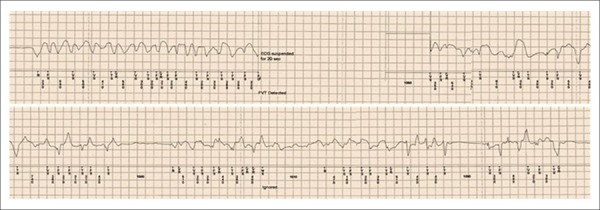
Fatal ventricular tachycardia/fibrillation episode recorded by the implantable
loop recorder.